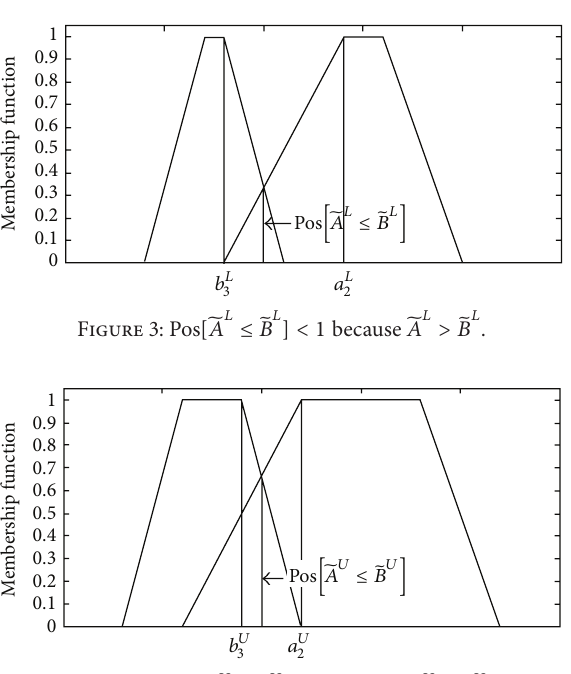
̃𝐴 𝑈 > ̃𝐵 𝑈 because